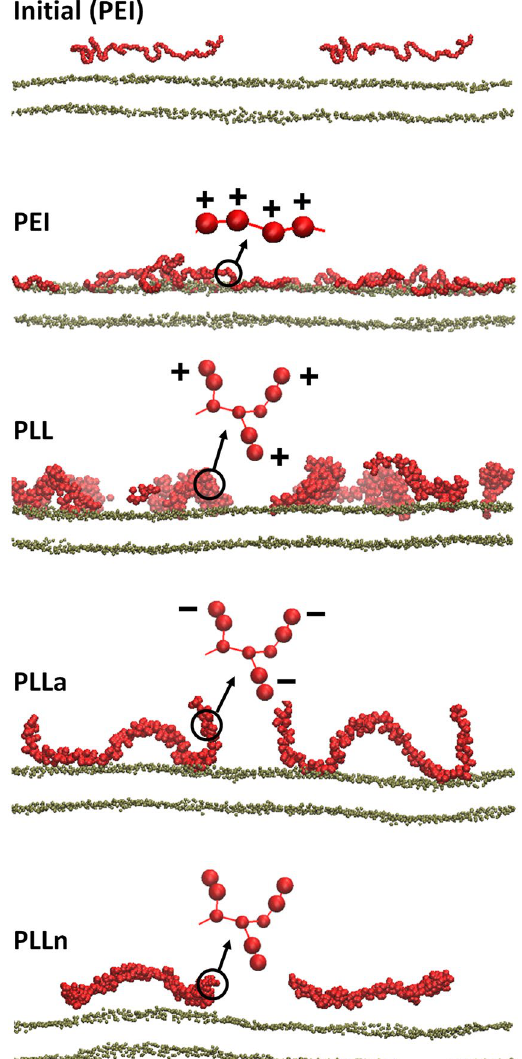
Figure 5. Snapshots of the side view at the beginning (0 ns; top) and the end (400 ns; rows 2–5) of the simulations. The initial configuration is shown only for PEI, but for other systems, the polymer chains are also similarly distributed above the bilayer surface. Red and brown colors represent polymers and lipid phosphates, respectively. Schematic structures of polymers are shown with charges, whereas lipid tails, water, and counter ions (Na + or Cl − ) are omitted for clarity. Note that the side views show only one cross-section of the system and cannot capture all eight polymer chains. The images were created using Visual Molecular Dynamics 25